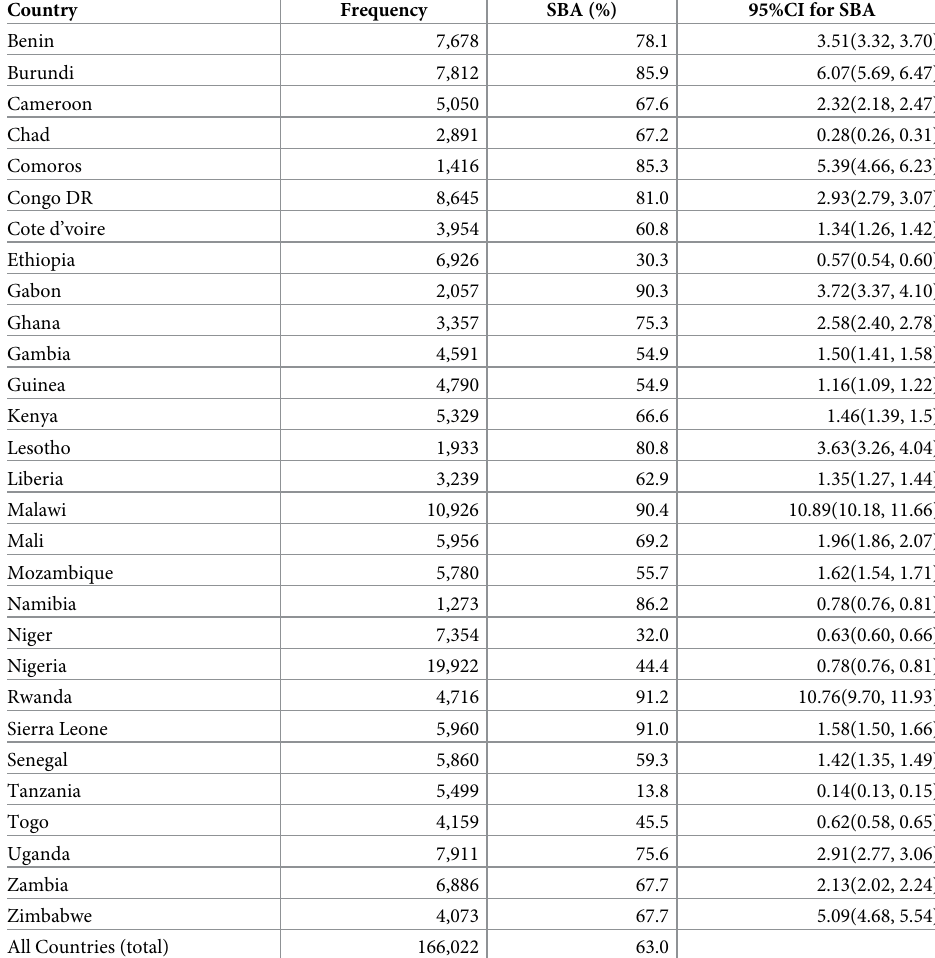
Table 1. Participant number, % and SBA practices in different countries in SSA.